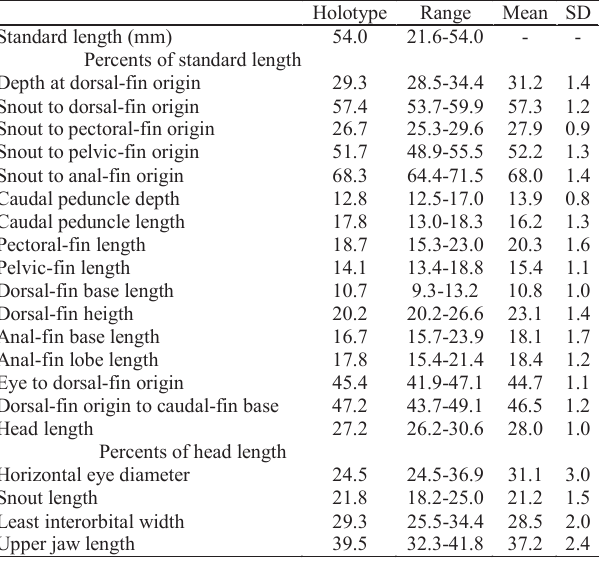
Table 1. Morphometric data of holotype and paratypes of Hasemania piatan (n = 40). The range includes the holotype. SD = standard